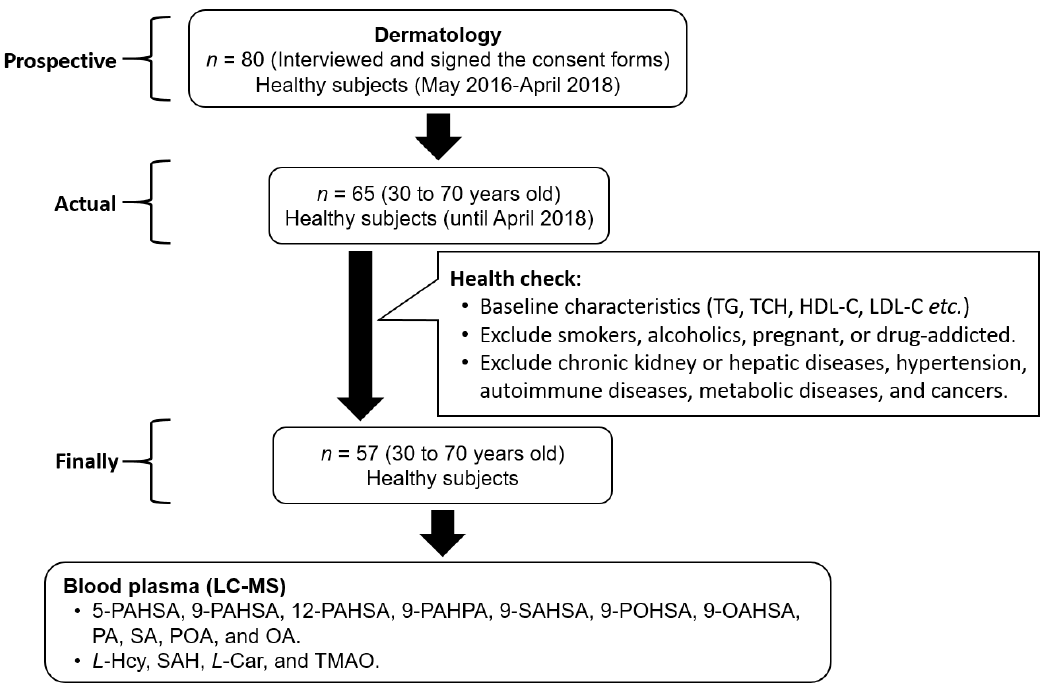
Figure 1. Flow diagram of healthy subject enrollment.